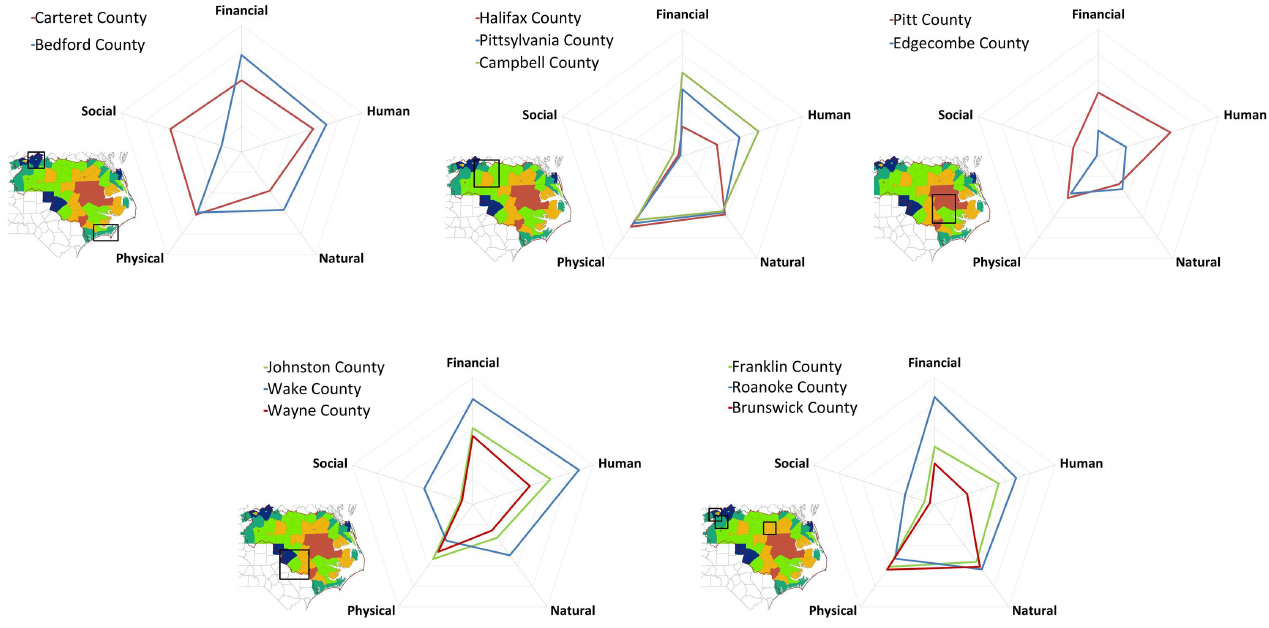
Fig. 4 . Five capital assets contributing to composite HWB measures compared across counties in the Albemarle–Pamlico basin. Values for each capital asset range from 0 to 1. Composite HWB values also range from 0 to 1 and are provided in legend. Top (left to right): Carteret and Bedford counties; Halifax, Pittsylvania, and Campbell counties; Pitt and Edgecombe counties; Bottom (left to right): Johnston, Wake, and Wayne counties; Franklin, Roanoke, and Brunswick